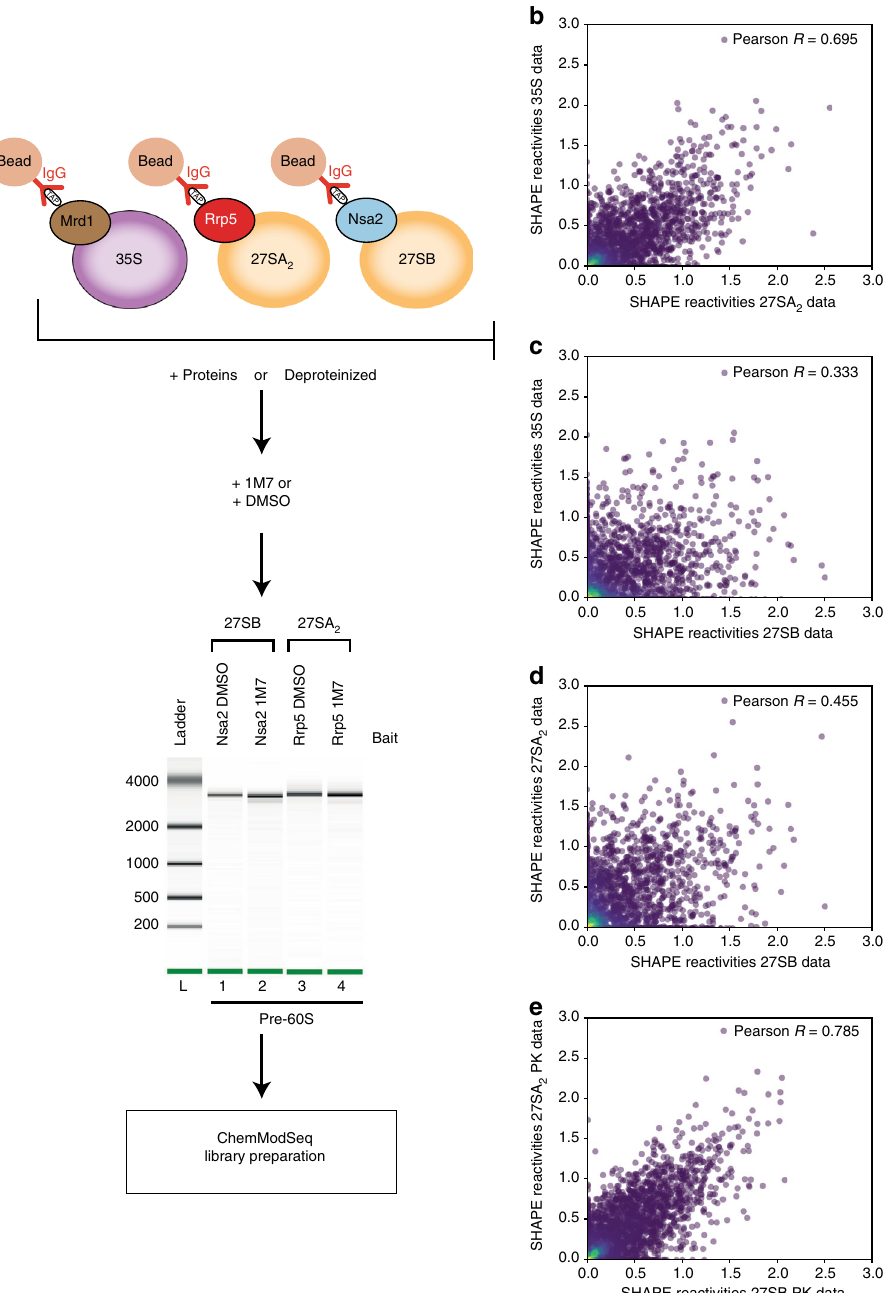
Fig. 2 ChemModSeq experimental work fl ow and data analysis. a Particles containing the 35S, 27SA 2 , and 27SB pre-rRNAs were puri fi ed using TAP-tagged Mrd1, Rrp5, or Nsa2 as baits, respectively. Chemical probing was performed on the puri fi ed particles as well as PK-treated particles. As controls for natural primer extension stops, we also incubated puri fi ed particles and PK-treated particles with the 1M7 solvent (DMSO). The rRNAs were gel puri fi ed and their integrity was assessed on a bioanalyzer chip. b – e Many conformational changes take place between the 27A 2 and 27SB particles. Shown are scatter plots that compare normalized SHAPE reactivity values of the 35S data to 27SA 2 and 27SB data ( b ) and ( c ) and 27SA 2 compared to 27SB data ( d ). Data generated from deproteinized particles is shown in e . The similarity between the data sets was determined by calculating Pearson correlation coef fi I, II, V, and VI are formed by L4/uL4, L17/uL22, and L42/eL43 during the conversion of 35S to 27SB pre-rRNA (Fig. 4a).